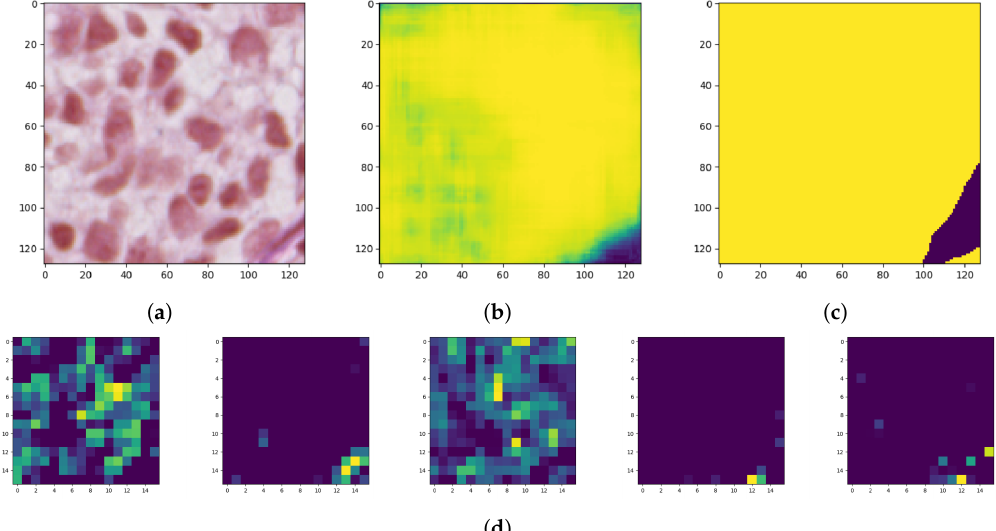
Figure 9. Feature maps of the autoencoder convolutional layers: ( a ) original image, ( b ) generated mask, ( c ) ground-truth image, and ( d ) a partial feature map from latent layers (only a few more interesting activations were